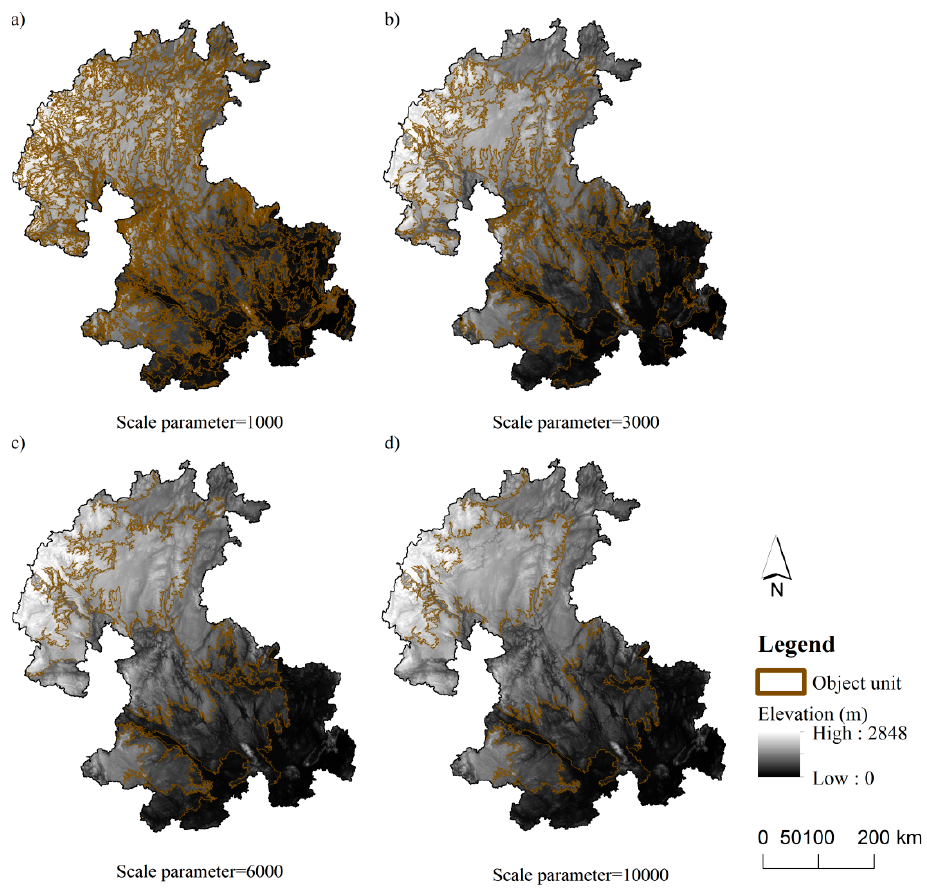
Figure 5. Elevation-based stratifications at the scale parameter of ( a ) 1000; ( b ) 3000; ( c ) 6000; ( d ) 10,000.